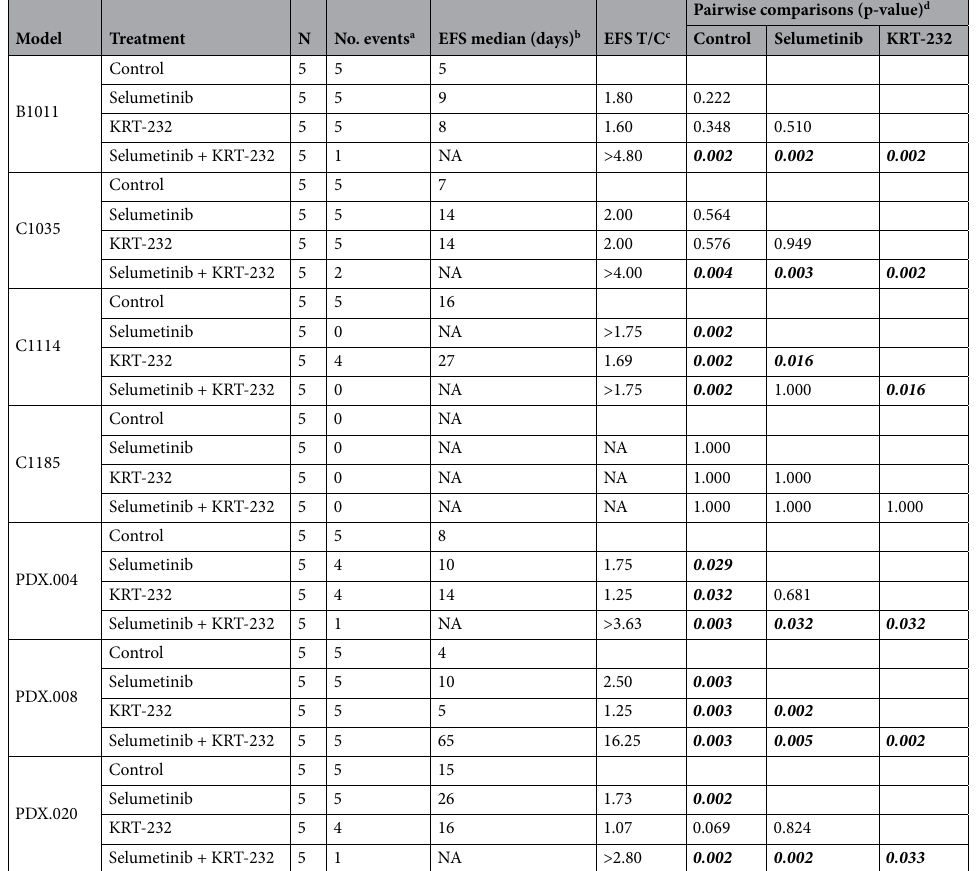
Table 1. Event-free survival ( EFS) estimates of selumetinib-, KRT-232-, and combination-treated CRC and PTC PDX models. a An event in each animal was defined as a doubling of tumor volume from initial tumor volume. b EFS was defined as the time interval from initiation of study to the first event or to the end of the study period for tumors that did not double in volume. c EFS T/C value was defined by the ratio of the median time to tumor doubling of the treatment group and the median time to tumor doubling of the control group. If the treatment group did not reach a doubling of tumor volume from initial tumor volume, then EFS T/C was defined as greater than the ratio of the last day of the study for the treatment group divided by the median time to tumor doubling for the control group. d Log-rank test was used to compare survival distributions of two treatment groups. p -values < 0.05 were regarded as significant and are shown in bold italics. NA not available.